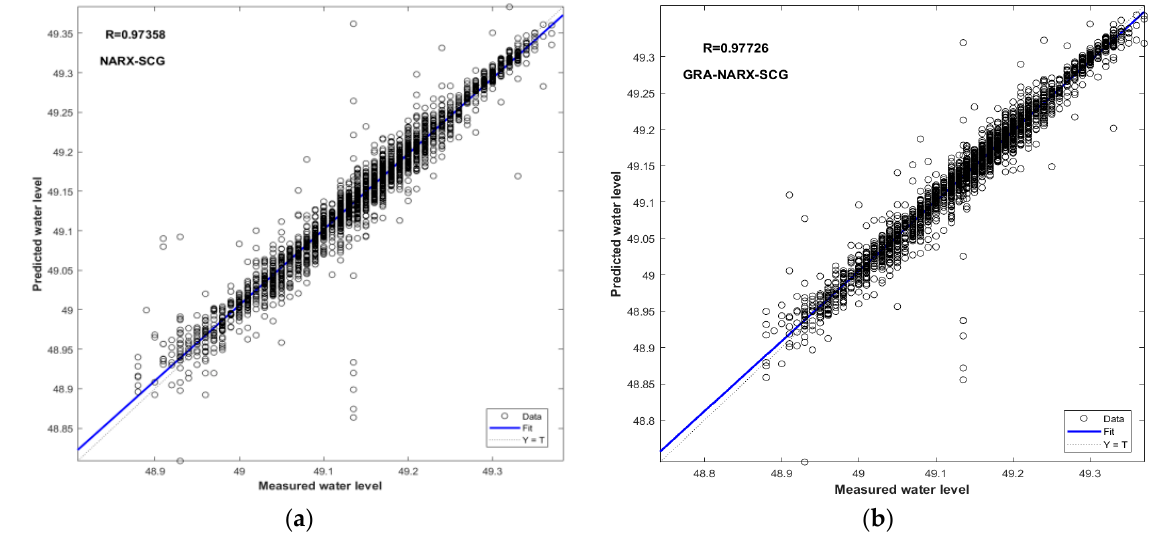
Figure 8. Scatter plots of measured and predicted water levels for the GRA-NARX and NARX models using SCG as the training algorithm: ( a ) NARX-SCG, ( b ) GRA-NARX-SCG.